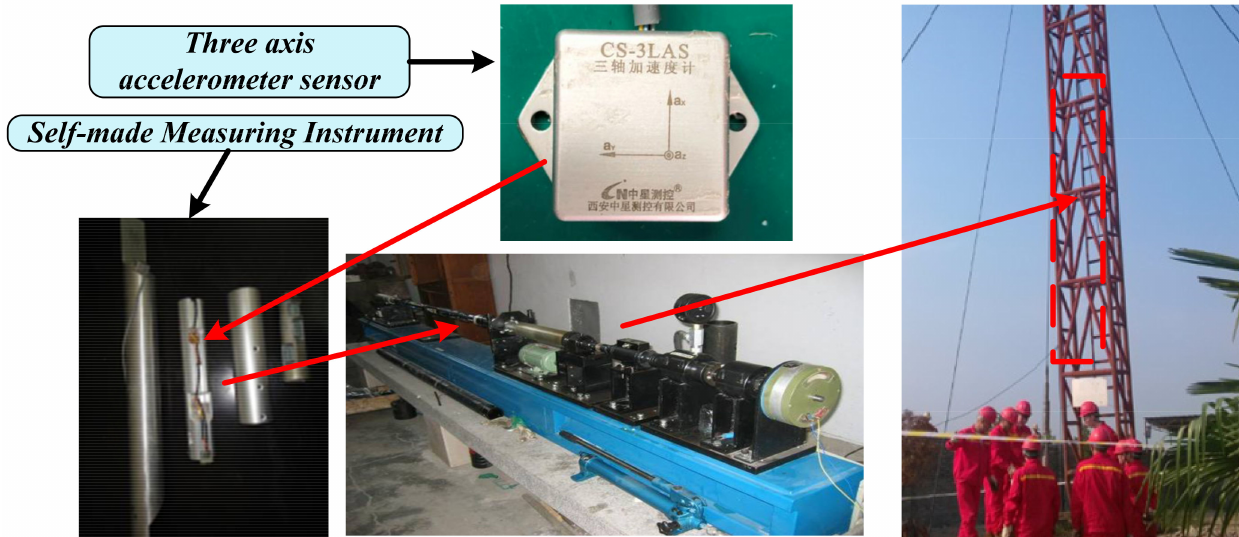
Figure 8. Schematic of the field test. The electronic circuit was installed in the axis of the drill collar near-bit, and the measurement data can be stored in